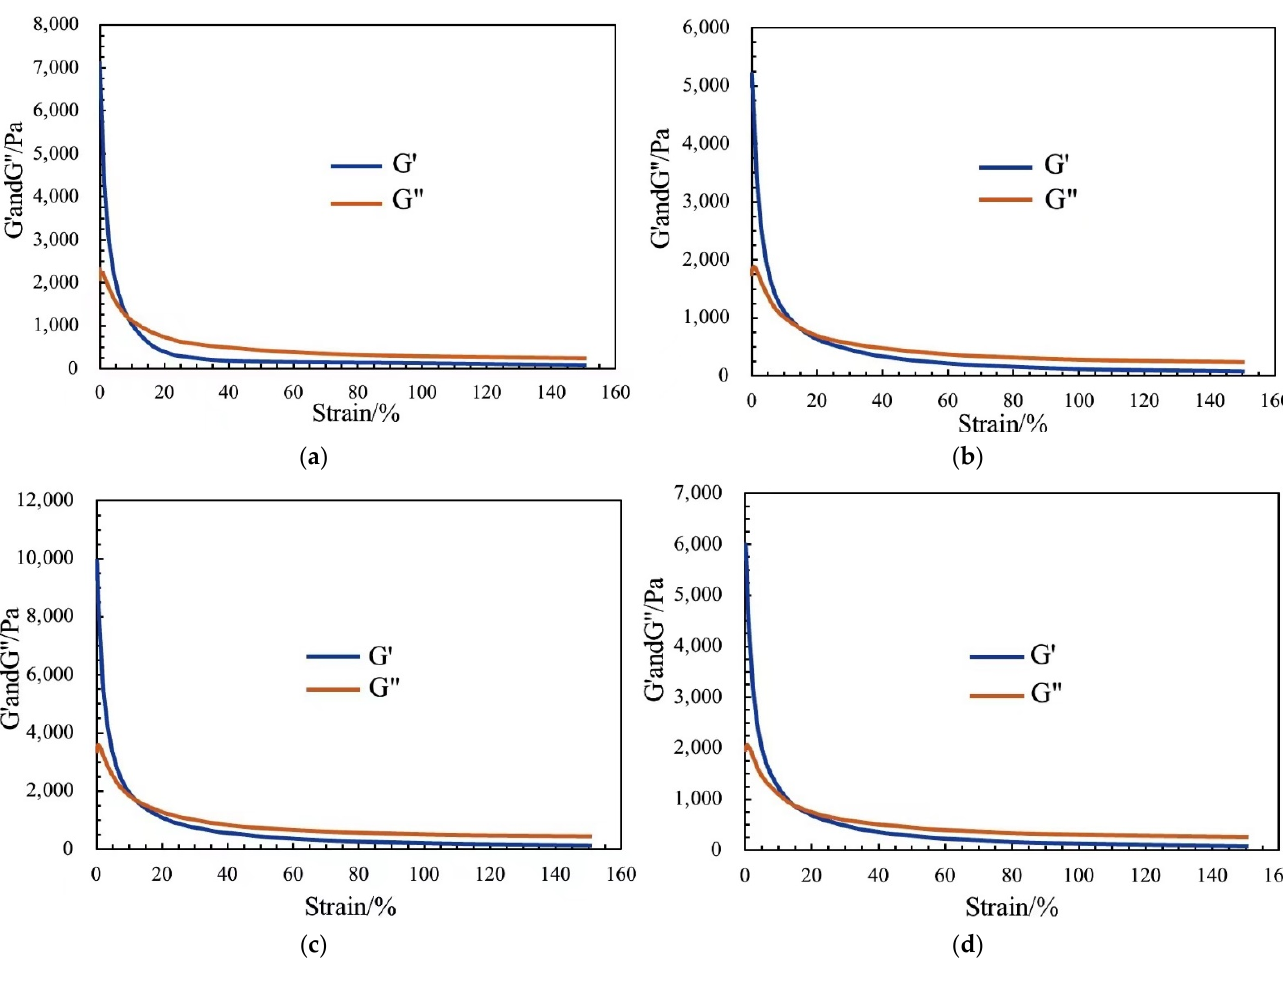
Figure 10. Modulus curve of grease after 7 rounds of freeze–thawing ( a ) PTFE; ( b ) Graphene; ( c ) CNTs; ( d ) WS 2 .